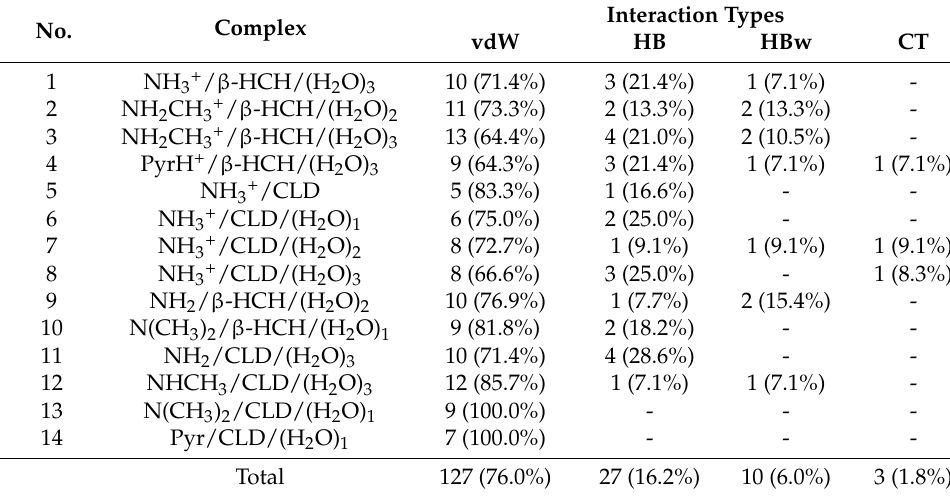
Table 3. Interaction types (%) present in the 14 distinctive minima structures by QTAIM results and using the Nakanishi